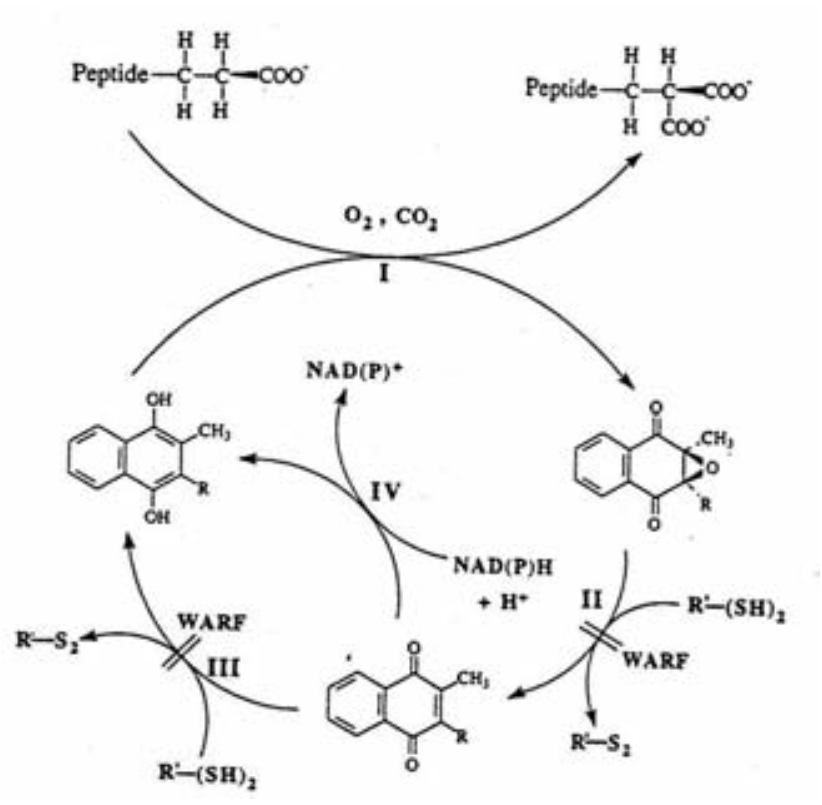
Figure 1. The enzyme reactions involved in the metabolic function of vitamin K. Vitamin K-dependent carboxylase catalyzes the transformation of peptide- (Factors II, VII, IX, and X) bound glutamate residues (Glu) to γ -carboxyglutamate (Gla) residues in the presence of vitamin K hydroquinone, carbon dioxide, and molecular oxygen (I). Vitamin K hydro- quinone is oxidized in the reaction to vitamin K 2,3 epoxide. The reduction of the latter to vitamin K quinone is catalyzed by vitamin K epoxide reductase, which can use certain dithiols as the reductants (II). Vitamin K quinone can be reduced to vitamin K hydro- quinone in the reactions catalyzed by either a dithiol-dependent (III) or an NAD(H)P- dependent (IV) entzyme. Warfarin (WARF) blocks reactions II and III. (Uotila L. Recent findings on the functions and requirements of vitamin K in humans. Klinlab